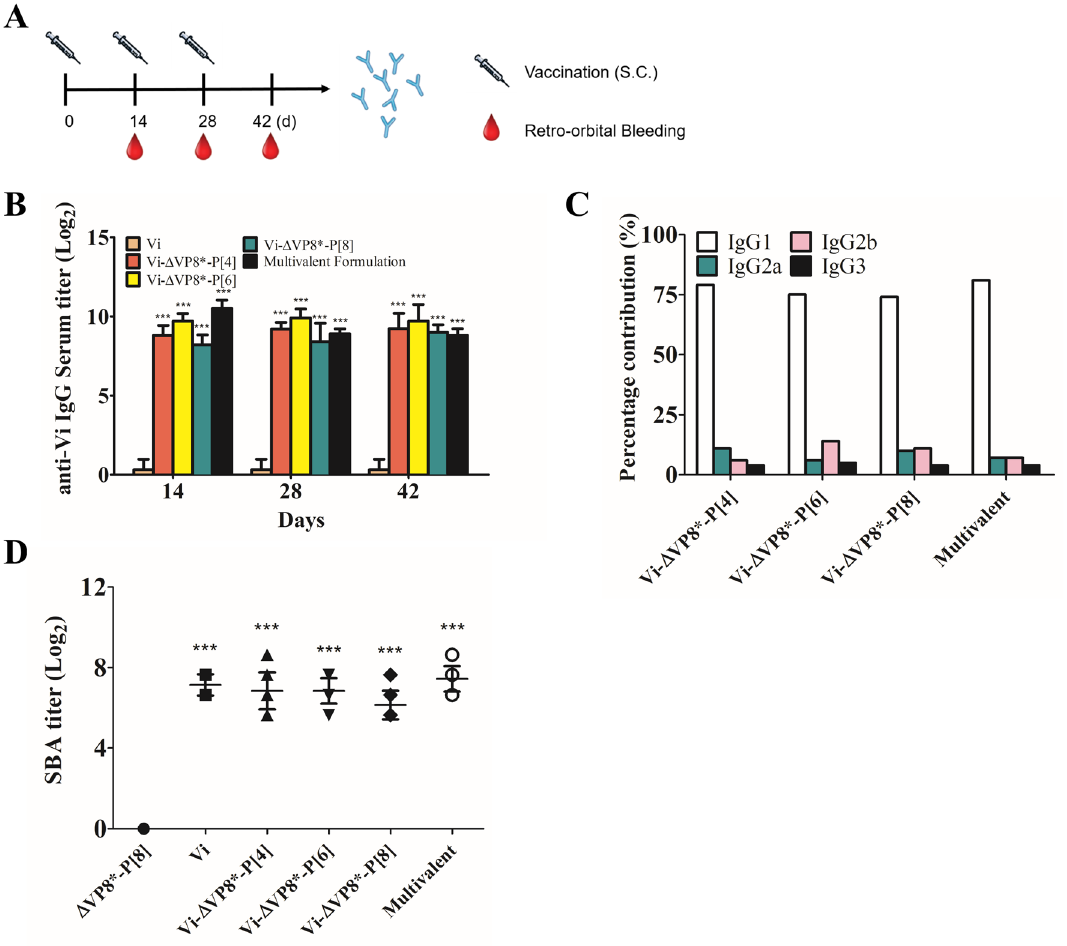
to total IgG against Vi. ( D ) Serum bactericidal activity (SBA) titers observed for sera from mice immunized with Vi-ΔVP8* conjugates. BALB/c mice were immunized SC with 5 μg of Vi-ΔVP8*-P[4], P[6] or P[8], or 15 μg of multivalent formulation based on Vi polysaccharide 3 times at 2-week intervals as described in Methods. Data were analyzed and illustrated using GraphPad Prism 6.0 software (GraphPad, https:// graph pad. com); data are mean±s.d.; two sample t -test; * P <0.05, ** P <0.01, *** P